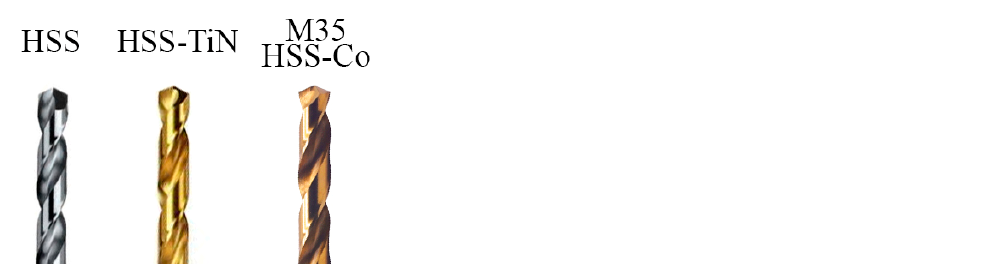
Figure 2. Images of high-speed steel (HSS), HSS coated with TiN (HSS-TiN), and M35 HSS-cobalt (HSS-Co) with new conditions.